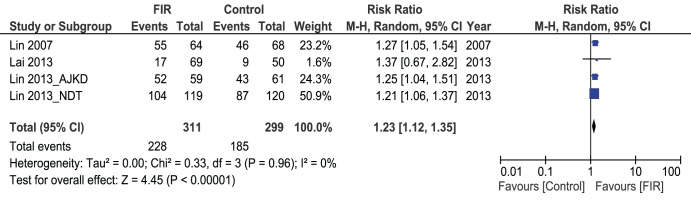
Forest Plot showing Primary AVFs patency at 12 months.